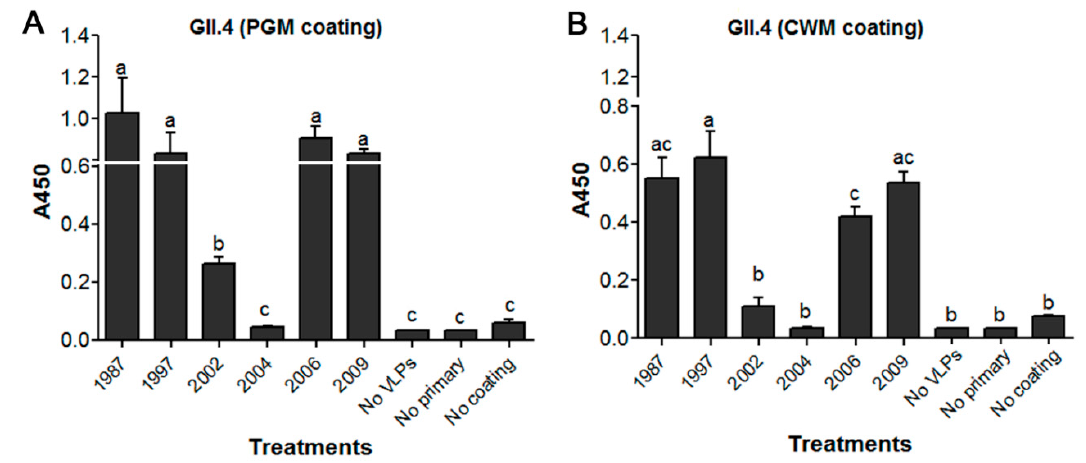
Figure 1. Enzyme linked immunosorbent assay (ELISA) screening of historical HuNoV GII.4 virus-like particles (VLPs) for their binding to ( A ) Porcine gastric mucin (PGM) and ( B ) lettuce leaves cell wall material (CWM). Means with different letters differ significantly.